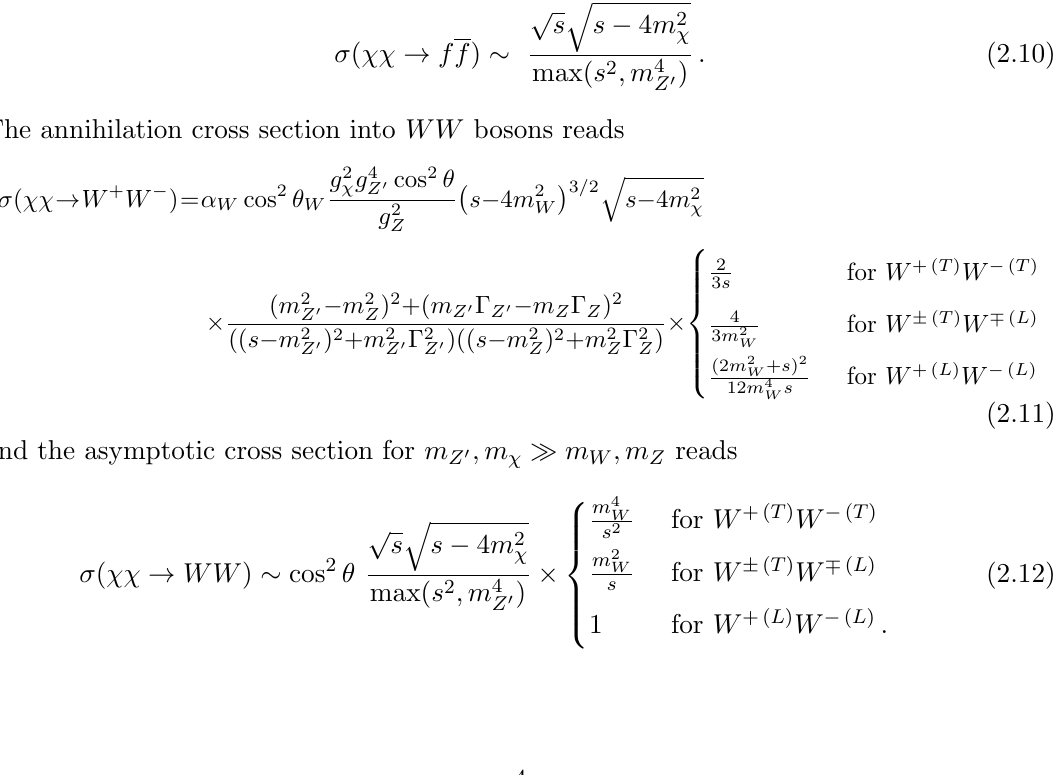
Figure 2 . ( Replaces (cid:12)gure 2 of the original paper .) Lower limits on the couplings g corresponding upper limits on the e(cid:11)ective scale (cid:3) = m Z 0 = ( g Z 0 p g (cid:31) ) from the requirement of not overclosing the universe. The gray shaded region in the upper panel correspond to a value of the couplings such that (cid:0) Z 0 > m Z 0 , signaling the breakdown of the perturbative